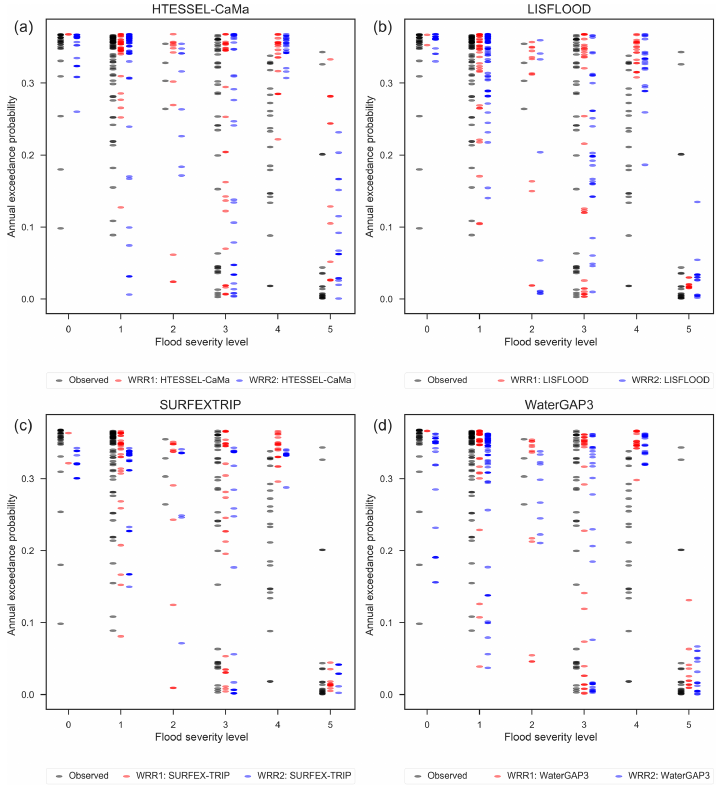
Figure 6. The relationship of the flood event severity for the reported flood events, and the corresponding annual exceedance probabilities that were observed and modelled for (a) HTESSEL-CaMa, (b) LISFLOOD, (c) SURFEX-TRIP and (d)